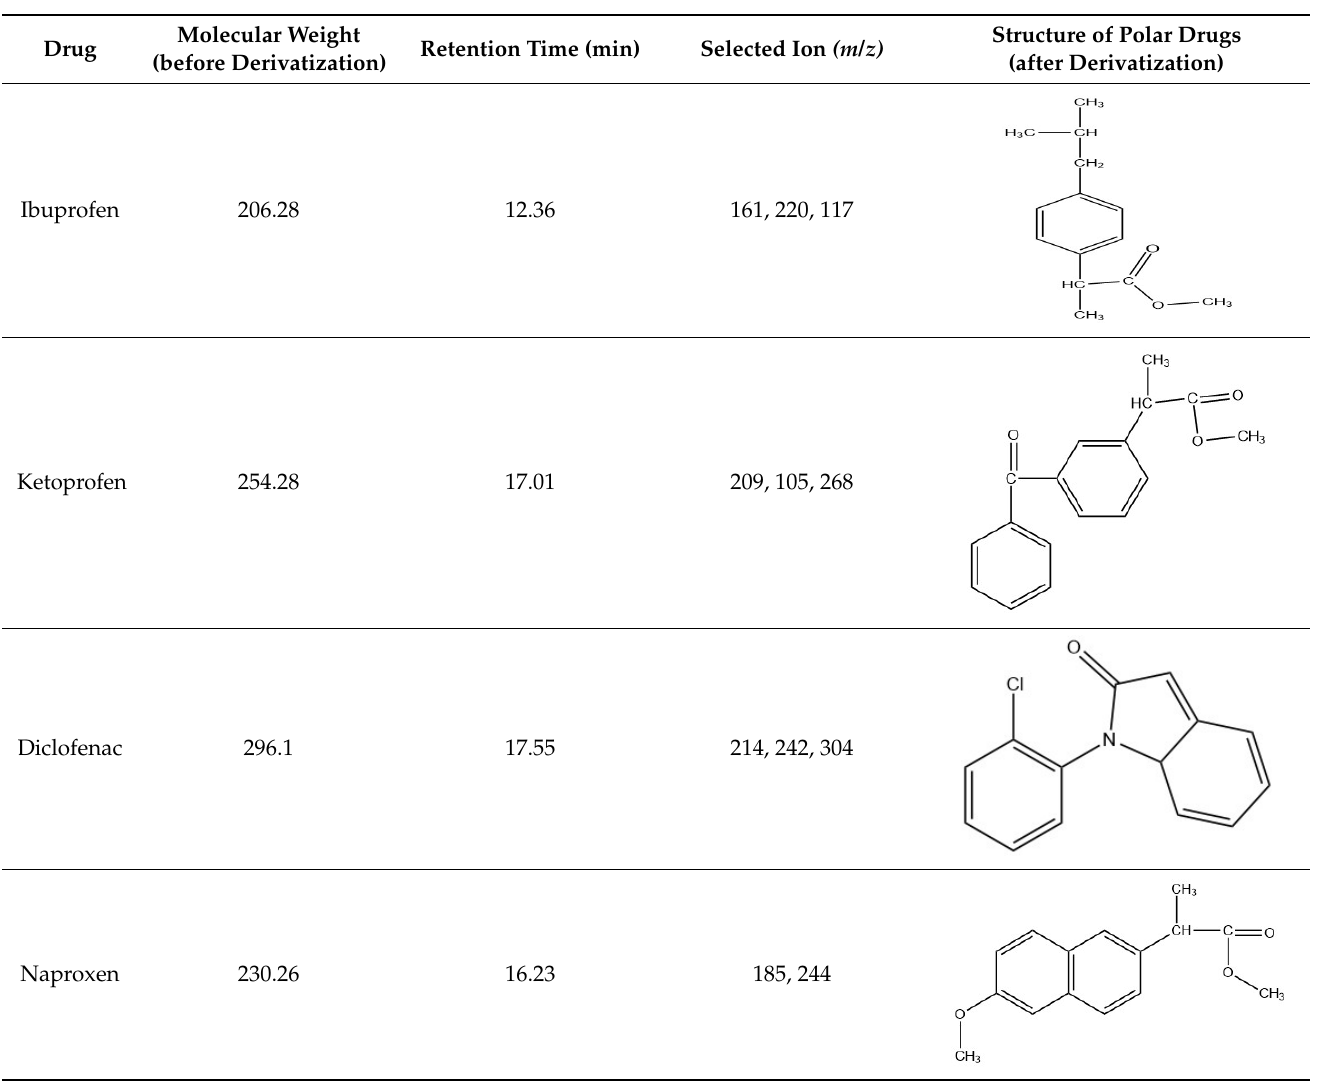
Table 7. Selected Physicochemical properties of the analytes, GC–MS retention times and prominent ions.